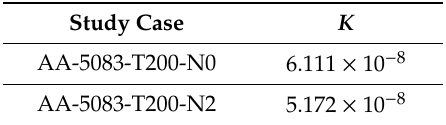
Table 2. Dimensional wear coefficients K (MPa −1 ).